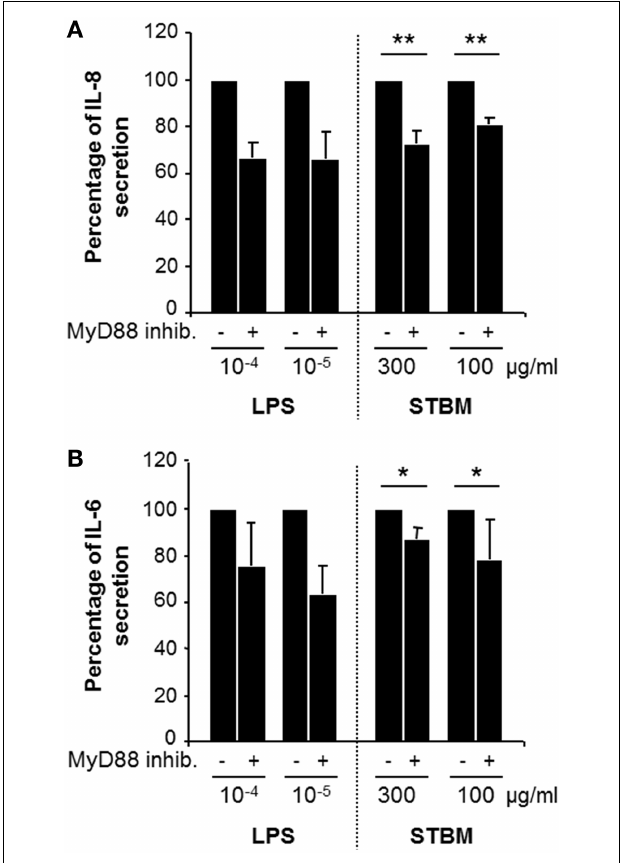
FIGURE 4 | Inhibition of MyD88 homodimerization reduces STBM-induced pro-inflammatory response. Primary monocytes were pre-treated with 1 µ M MyD88 inhibitor peptide for 24h prior incubation with the indicated concentrations of LPS or STBM-NP during 12h.The concentrations of IL-8 (A) and IL-6 (B) secreted by the cells were quantified by ELISA and are presented as a percentage of the amounts secreted in absence of pre-treatment with the inhibitor. Data represent mean ± SEM of three monocyte co-culture experiments with STBM-NP prepared from four placentas. * p < 0.05; ** p < 0.01. LPS was used as a positive